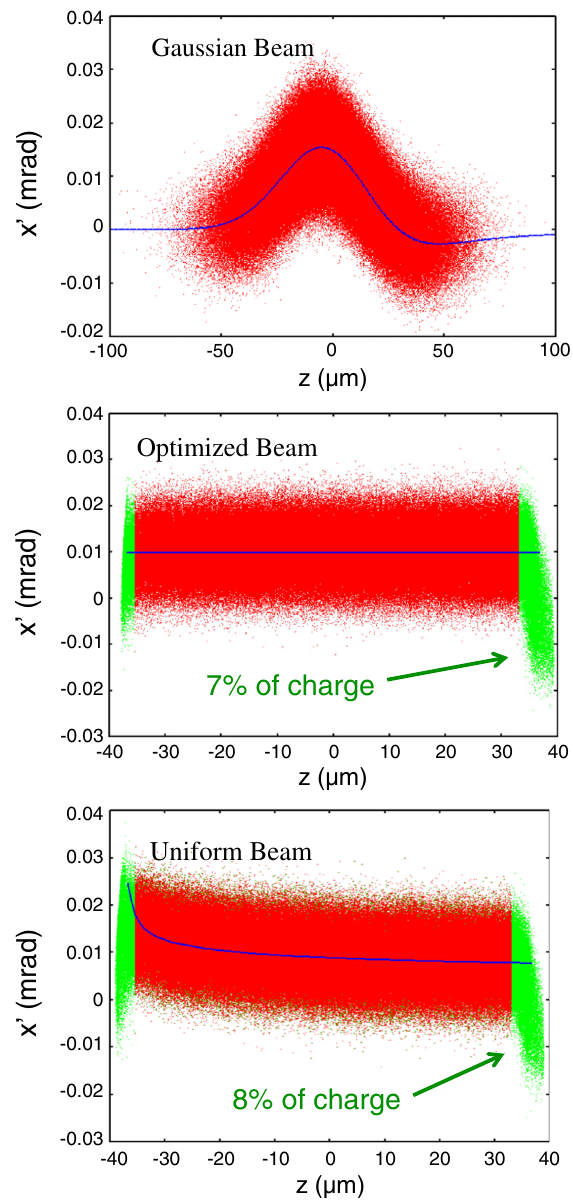
FIG. 11. Projection of the final beam distribution at the exit of the system shown in Fig. 6 into the x 0 (cid:1) z phase plane for the three initial profiles shown in Fig.